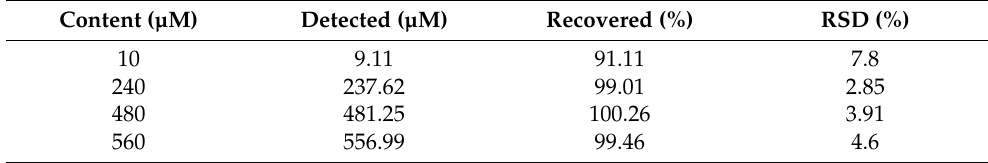
Table 2. Dopamine determination using the BT/rGO-modified GCE in injected dopamine